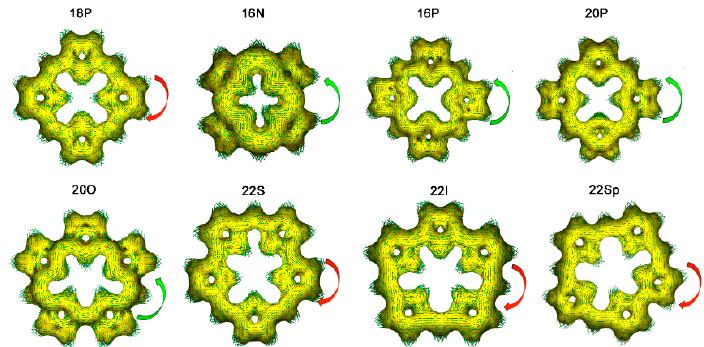
Figure 3. AICD plots of Hückel porphyrinoids. The large arrow denotes the direction of the induced ring current: clockwise for diatropic ring currents and anticlockwise for paratropic ring currents (isosurface value 0.03 a.u.).